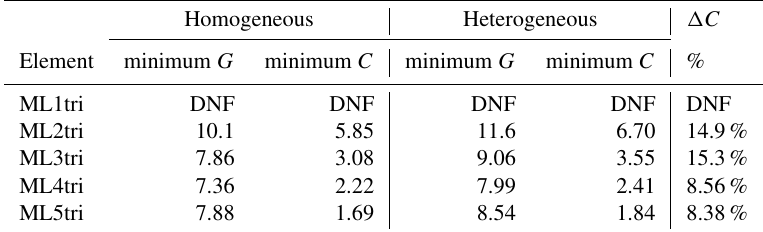
Table 2. Results from the grid sweep for both the homogeneous and heterogeneous experiment to identify efficient values for G using ML elements of varying spatial degree k that maintain an error threshold of E = 5%, as compared to a highly refined reference solution (see Sect. 5.2). Note that DNF stands for did not